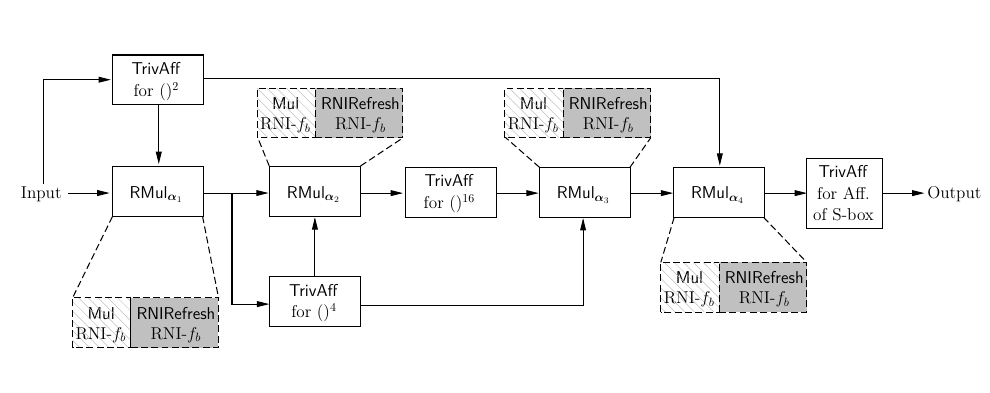
Figure 9: Masked implementation of AES S-box. Table 1: The randomness requirement of AES